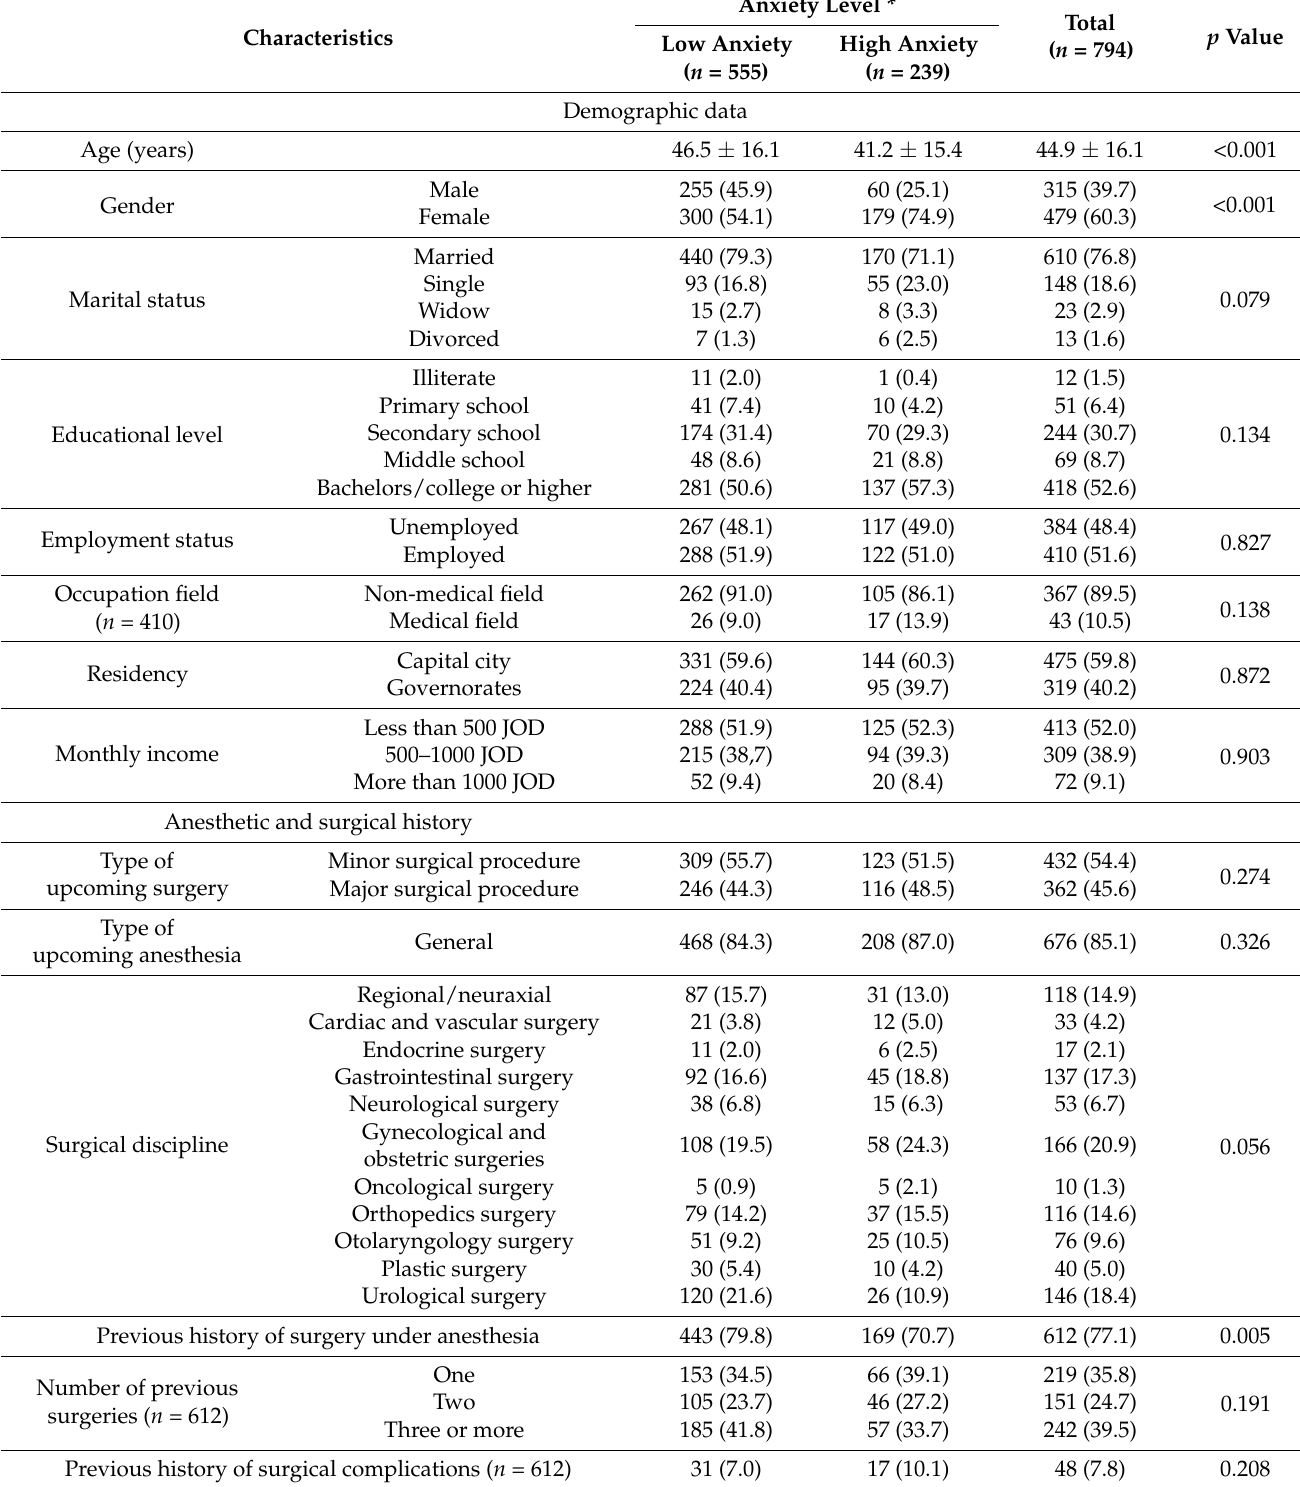
Table 1. A comparison between patients who had high preoperative anxiety and low preoperative anxiety in the demographic